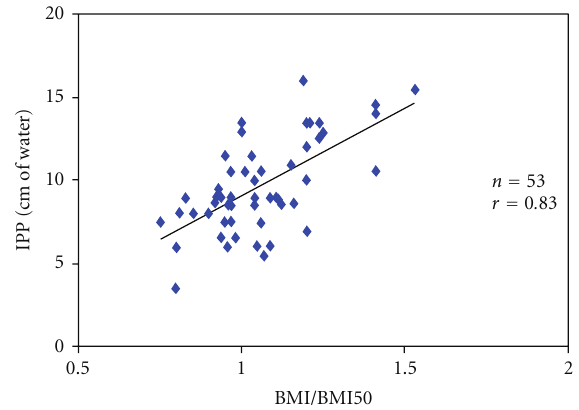
Figure 1: IPP is an individual patient characteristic, determined by BMI and dwell volume. The intraperitoneal pressure (IPP, y -axis) is positively correlated with the normalized body mass index ( x -axis) withinthe generalpopulation. This correlationis even stronger than the correlation between dwell volume to IPP [5].